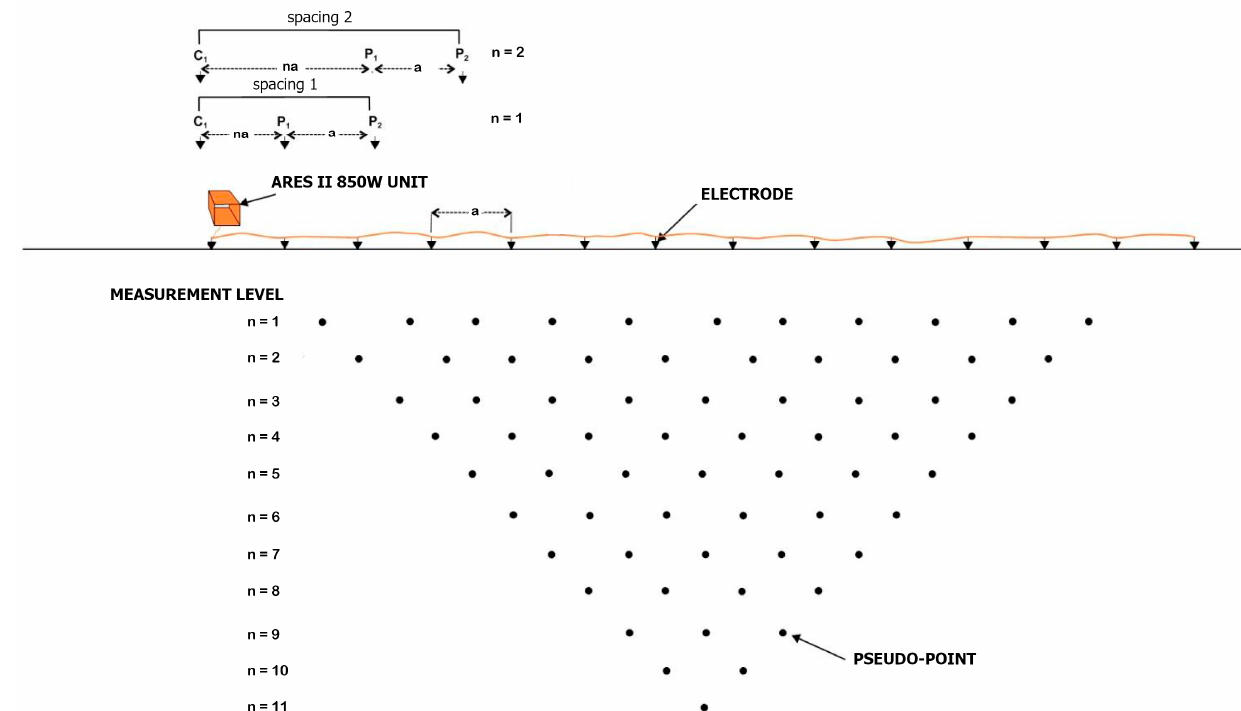
Figure 6. Scheme of ERT measurement with a three-electrode system method.